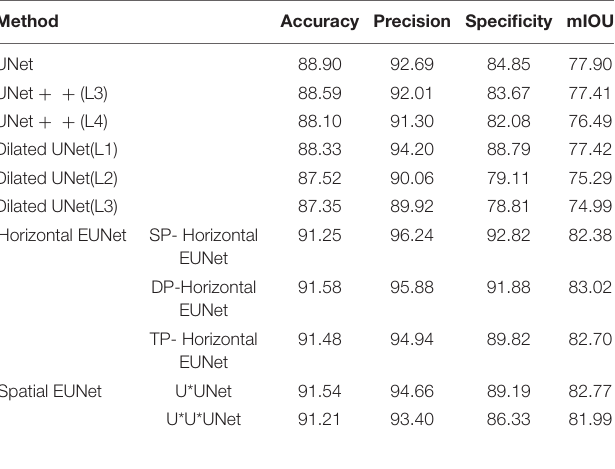
TABLE 2 | Segmentation performance comparison between EUNet and U-shaped network in MPM